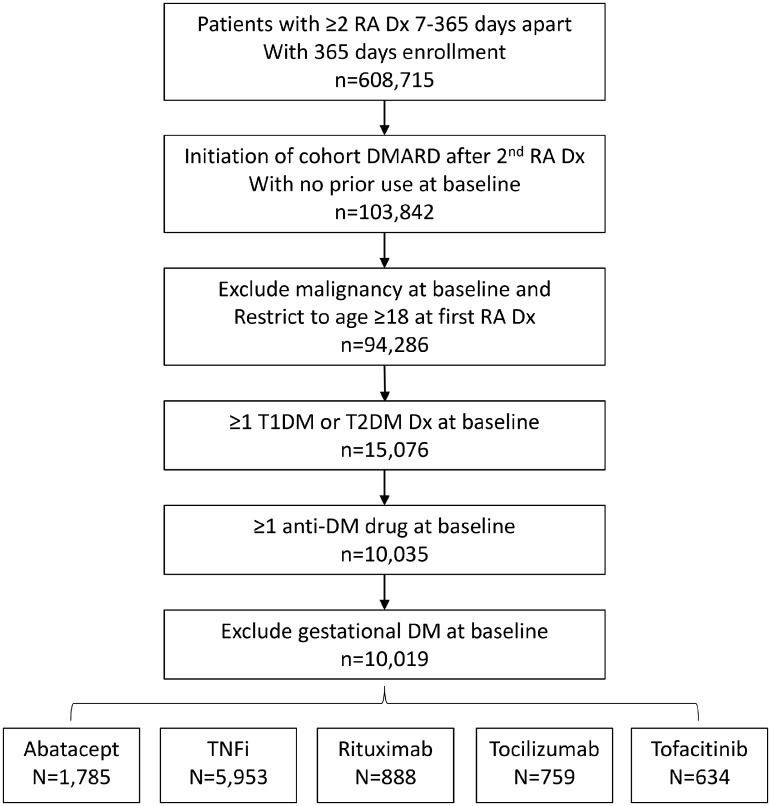
Flow diagram of cohort selection